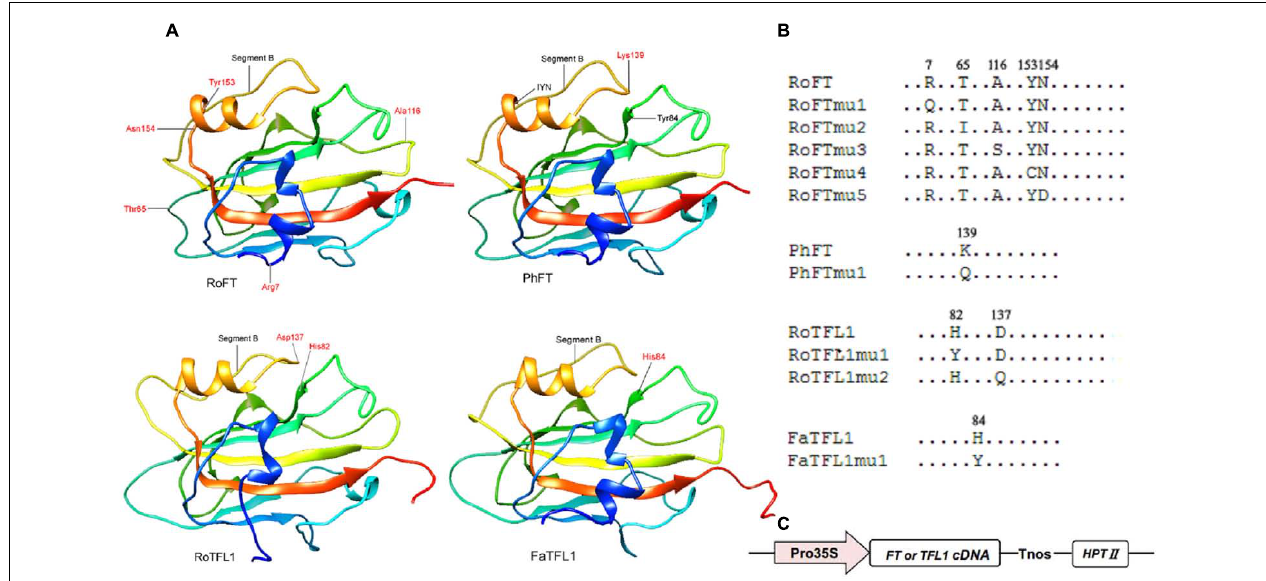
FIGURE 3 | Crystal structures of FT and TFL1 and maps of point mutated residues. (A) Cartoon diagrams of four FT or TFL1 homologs. The red high-lighted residues show the corresponding mutated points that were substituted for use in transgenic experiments. The protein pairs: RoFT/PhFT and RoTFL1/FaTFL1 present highly similar crystal structures to each other. (B) Diagram mapping the corresponding mutated amino acid residues of FT or TFL1 homologs. (C) Schematic map of the T-DNA region (vector pMOG22) used to perform the transgenic